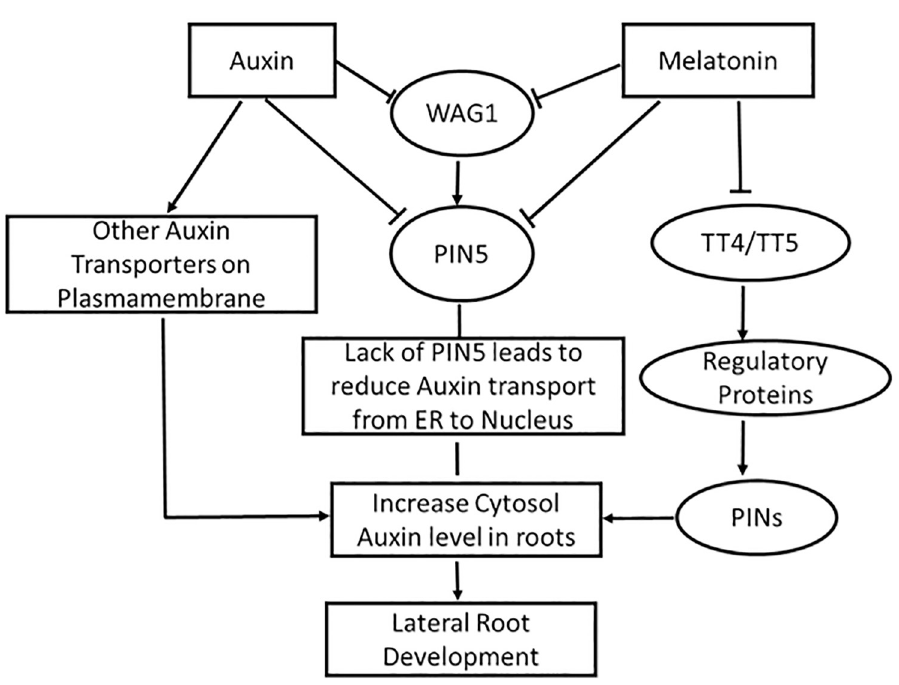
Fig 6. Working model describing the mechanism of auxin and melatonin in regulating lateral root